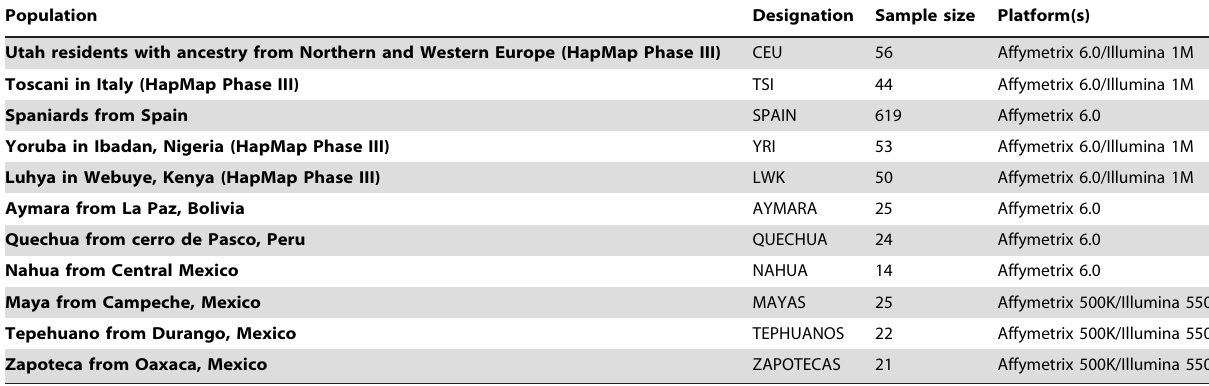
Table 5. Ancestral populations used for this